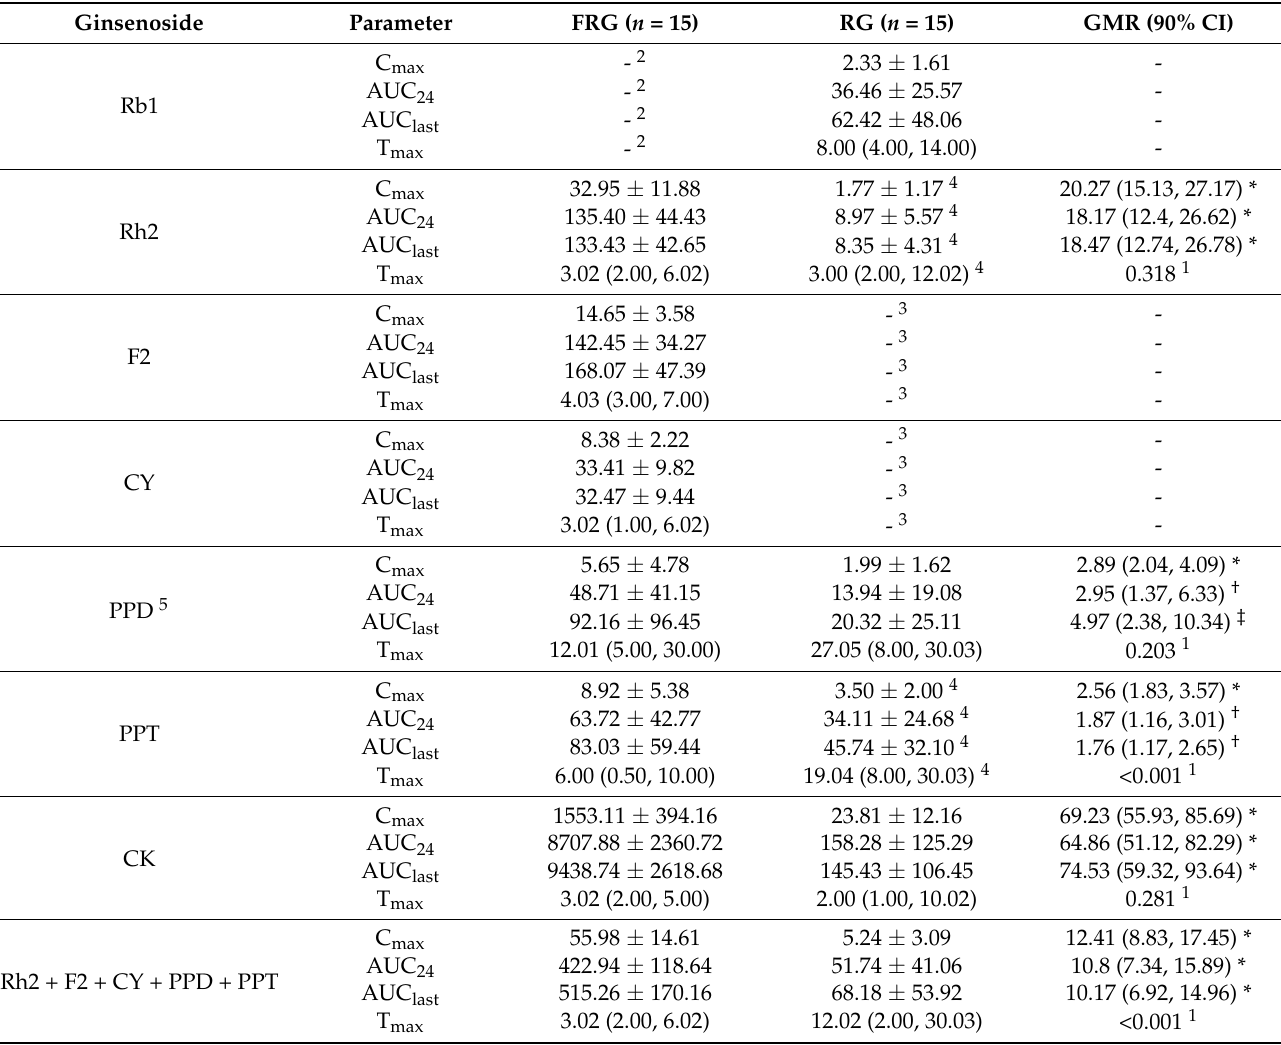
Table 2. Pharmacokinetic parameters of ginsenosides after receiving 6 g of fermented red ginseng (FRG) or red ginseng (RG) in healthy